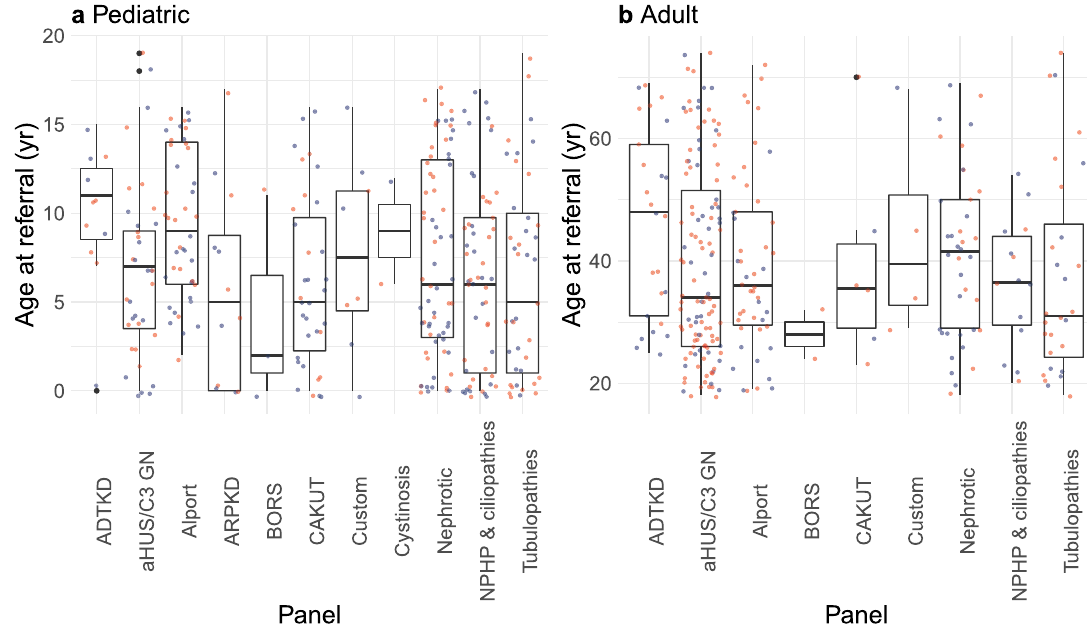
Fig. 1 Ages at referral by panel. a Distribution of ages at referral in the pediatric cohort ( n = 281 probands). b Distribution of ages at referral in the adult cohort ( n = 271 probands). Each data point represents a proband (blue = male; red = female) referred for the relevant panel. Filled black points indicate outliers (points beyond 1.5 times the interquartile range above the upper hinge [75th percentile] or below the lower hinge [25th percentile]). Abbreviated panels are as follows: ADTKD autosomal dominant tubulointerstitial kidney disease, aHUS/C3 GN atypical hemolytic uremic syndrome-C3 glomerulonephritis, Alport Alport syndrome, ARPKD autosomal recessive polycystic kidney disease, BORS branchio-oto renal syndrome, CAKUT congenital anomalies of the kidney and urinary tract, Nephrotic nephrotic syndrome, NPHP & ciliopathies nephronophthisis & related